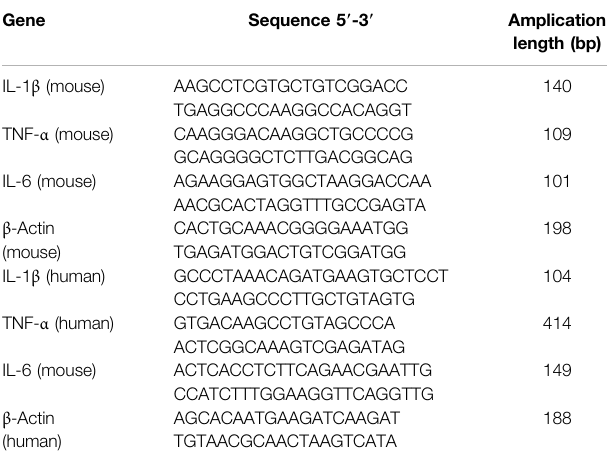
TABLE 1 | Primers ’ sequences used for real-time PCR